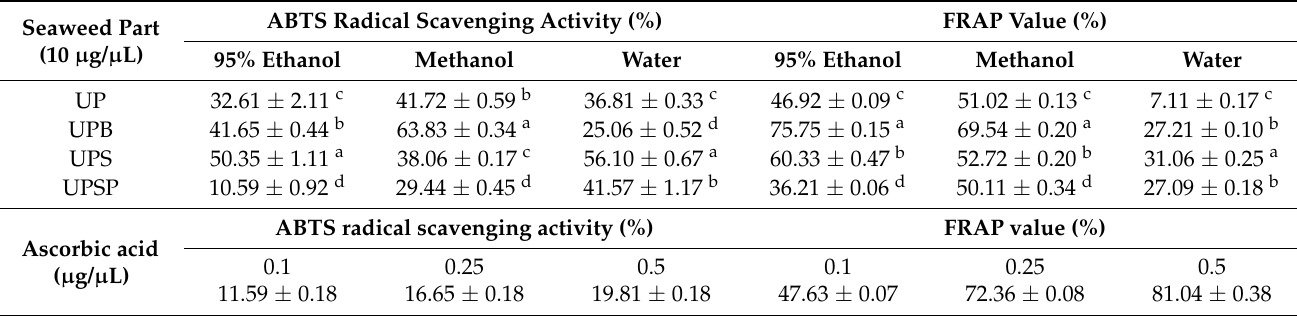
Table 3. ABTS radical scavenging activities (%) and FRAP values of different solvent extracts of different parts of Undaria pinnatifida